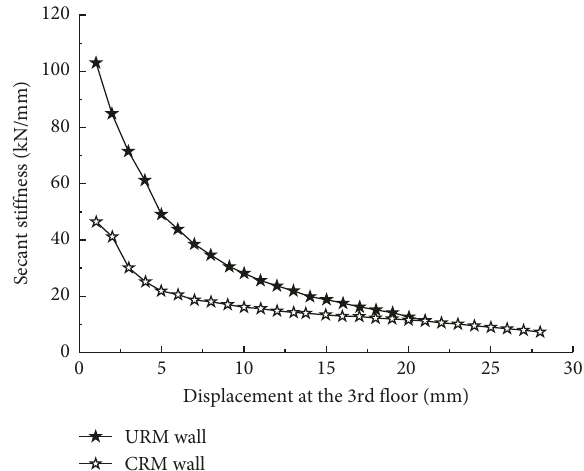
Figure 12: Secant stiffness degradation of URM and CRM